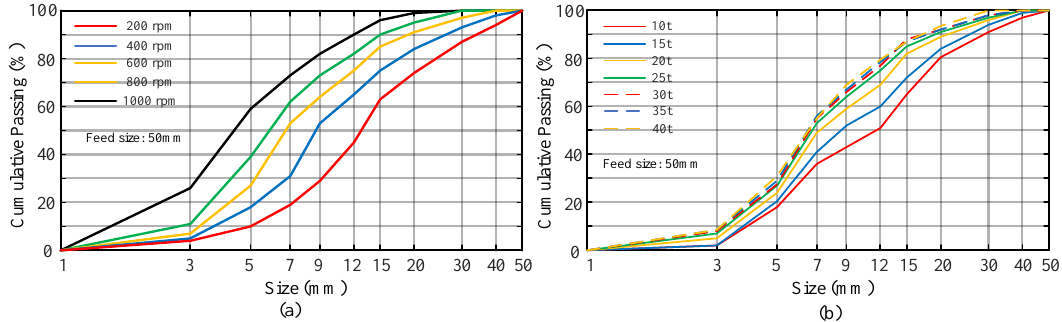
Figure 23. The effect of drive speed and fixed cone mass on product size distribution, simulation results as: ( a ) product size distribution for different speeds in the fixed cone mass 24 t case; ( b ) product size distribution for different masses in the 600 rpm case.